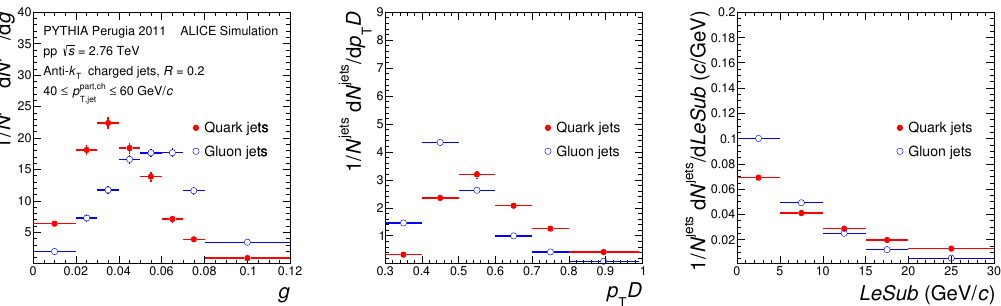
Figure 1 . g , p T D , and LeSub for quark and gluon jets as obtained from PYTHIA Perugia 2011 simulations of pp collisions at 60 GeV/ c